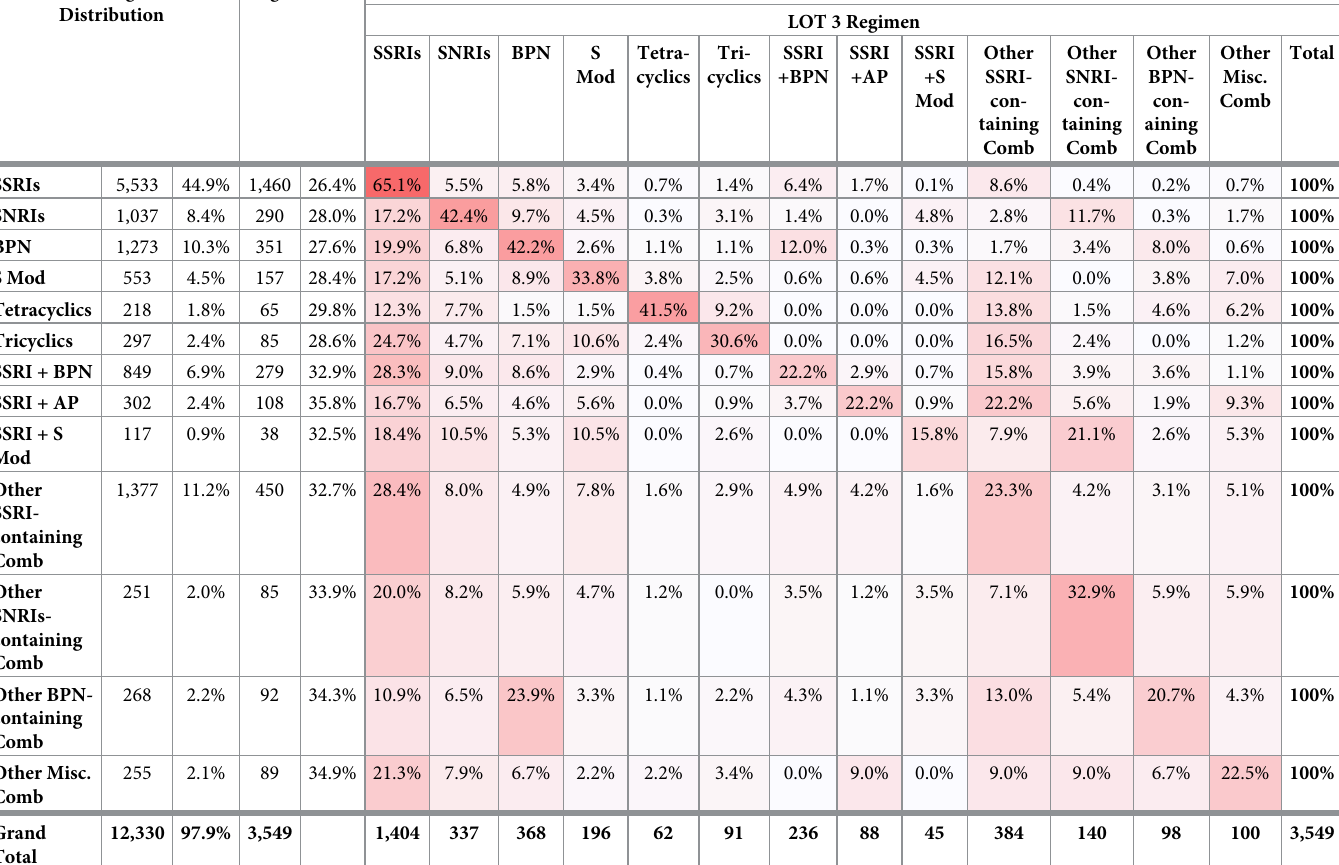
Table 2. Treatment sequence patterns from LOT2 to LOT3 during the 1 st treated MDD episode. LOT 2 Regimen